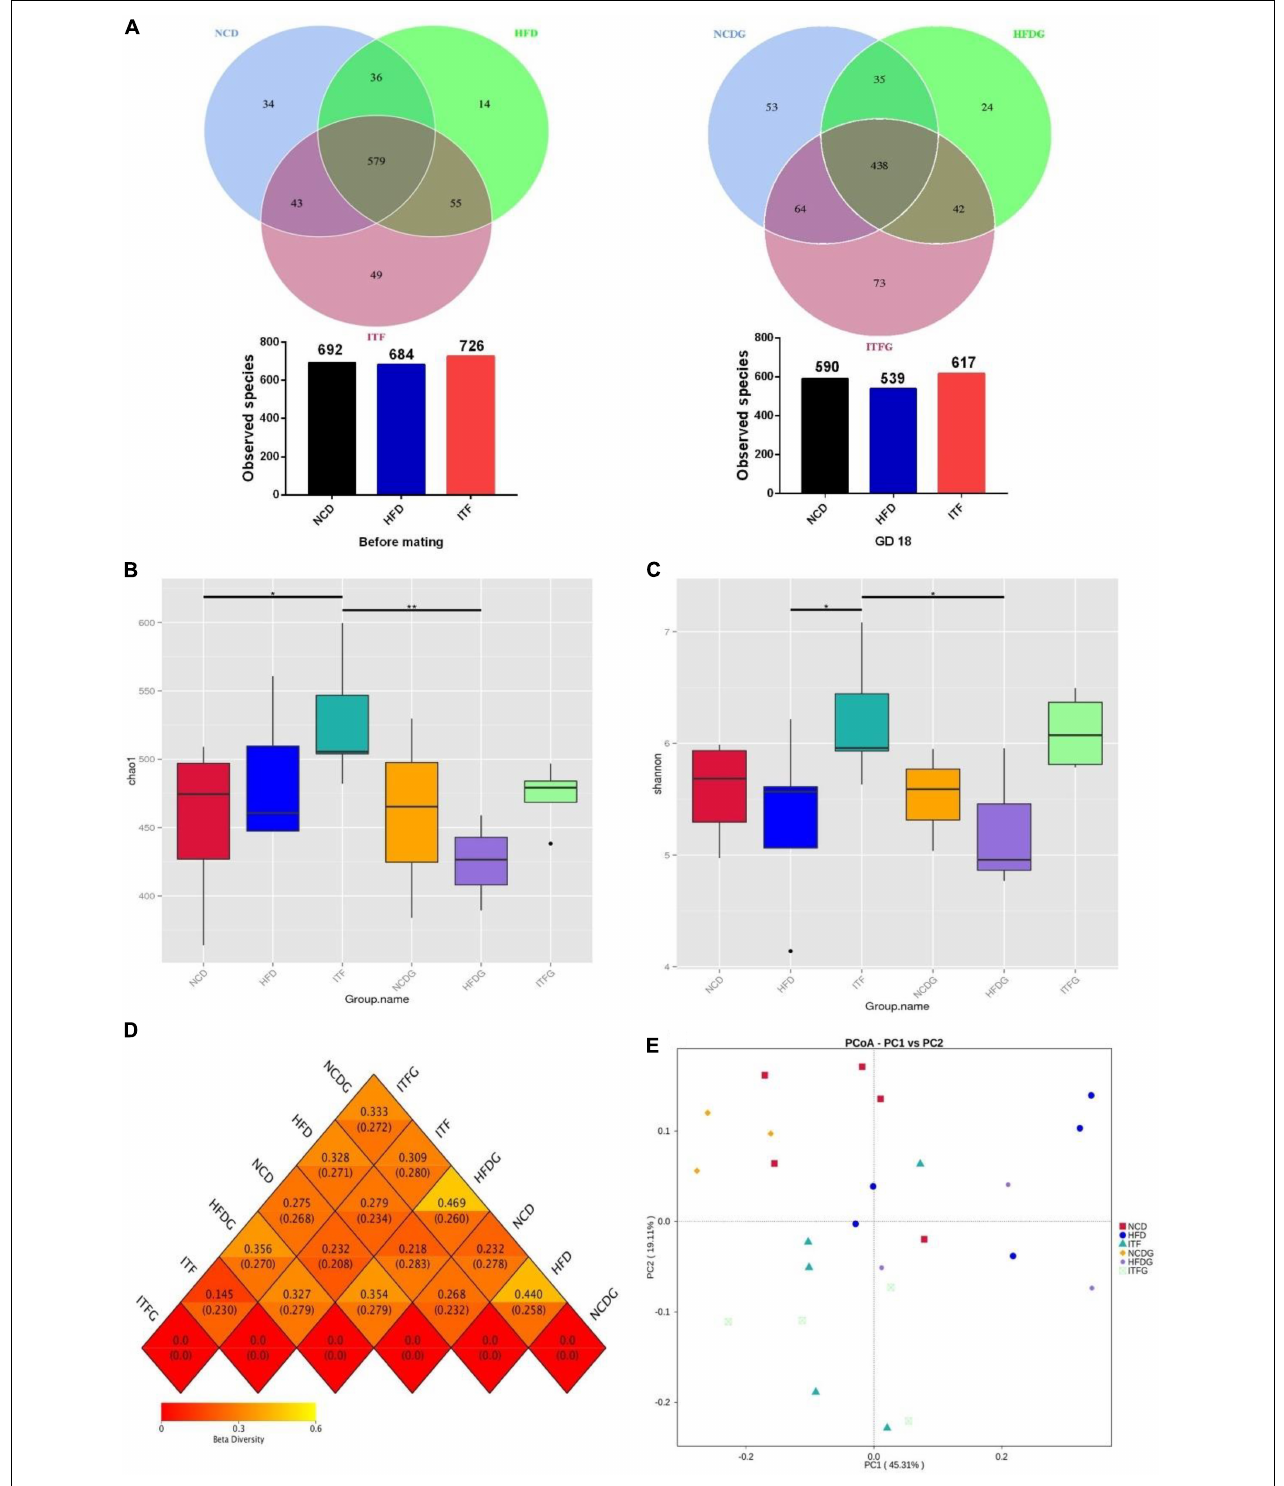
FIGURE 3 | ITF modify the composition of the cecal microbiota in ob/ob mice. (A) OTU number before mating and on GD18. (B) Chao 1 index of microbiota. (C) Shannon index of microbiota. (D) Heat map of beta diversity index. (E) The beta diversity of gut microbiota analyzed by PCoA. Data were analyzed using one-way ANOVA followed by the Tukey post hoc test for panels (B,C) . * p < 0.05, ** p < 0.01.